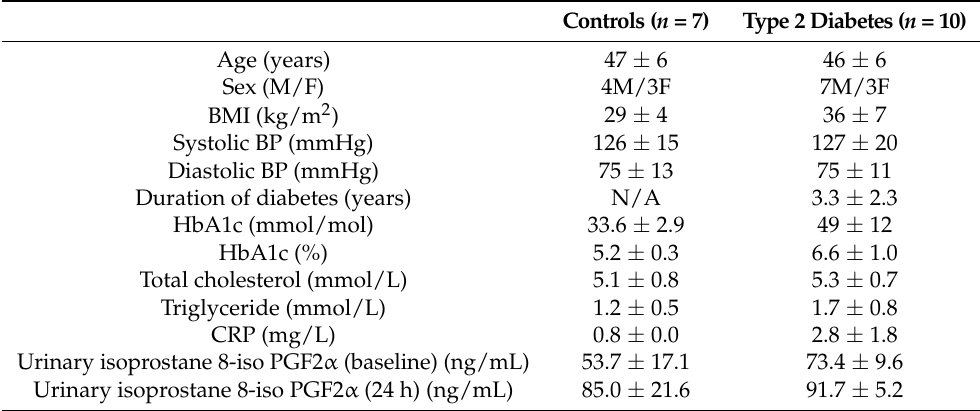
Table 1. Demographic and biochemical parameters of control and type 2 diabetic (T2D) subjects included in the study [21]. Data are presented as mean ± 1